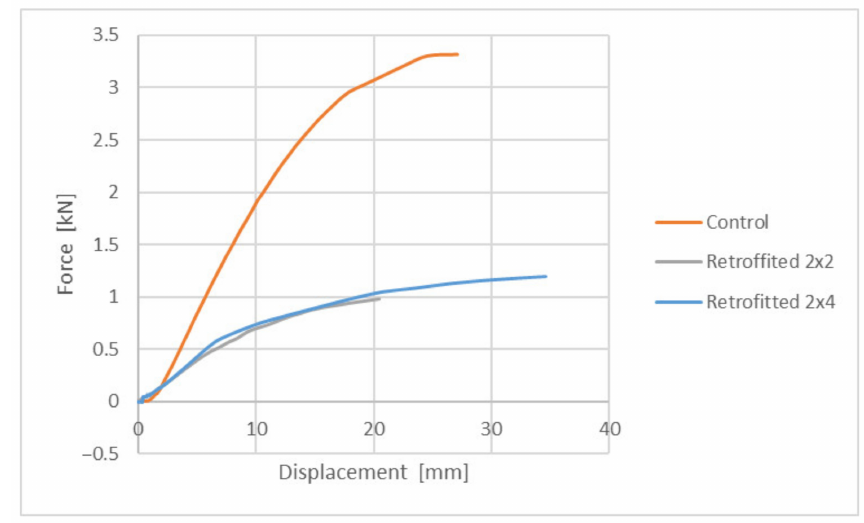
Figure 8. Behavior of samples rehabilitated with “liquid wood” subjected to